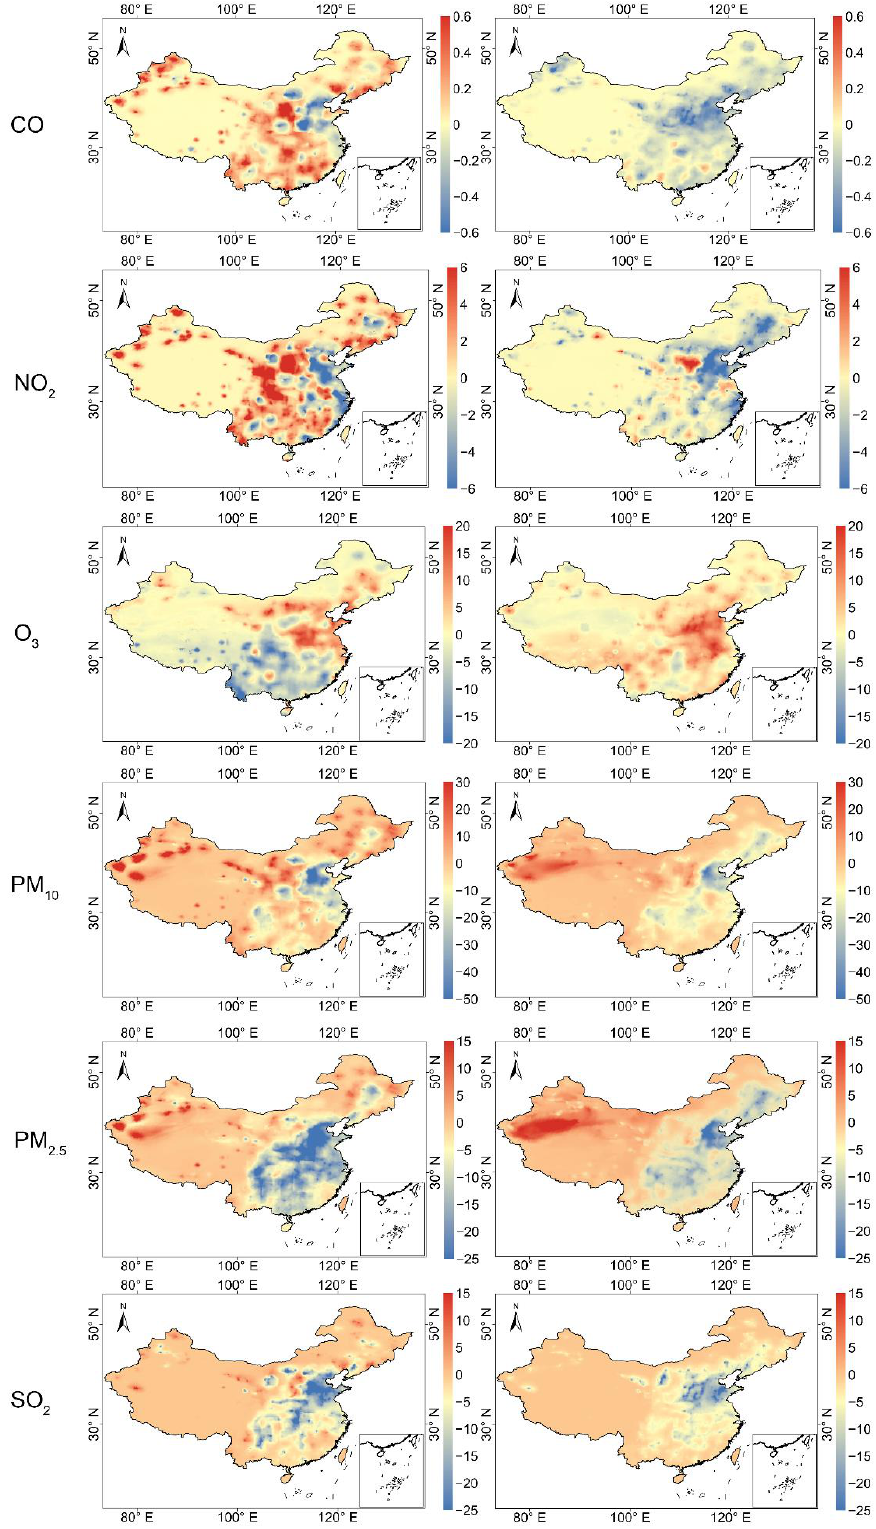
Figure 9. The variations in surface concentrations of six air pollutants (μgm −3 ) in China during the Air Pollution Prevention and Control Action Plan. The left column is the surface concentration of air pollutants in the OP phase minus the value in the PIP phase, and the right column is the surface concentration of air pollutants in the PCP phase minus the value in the OP phase.